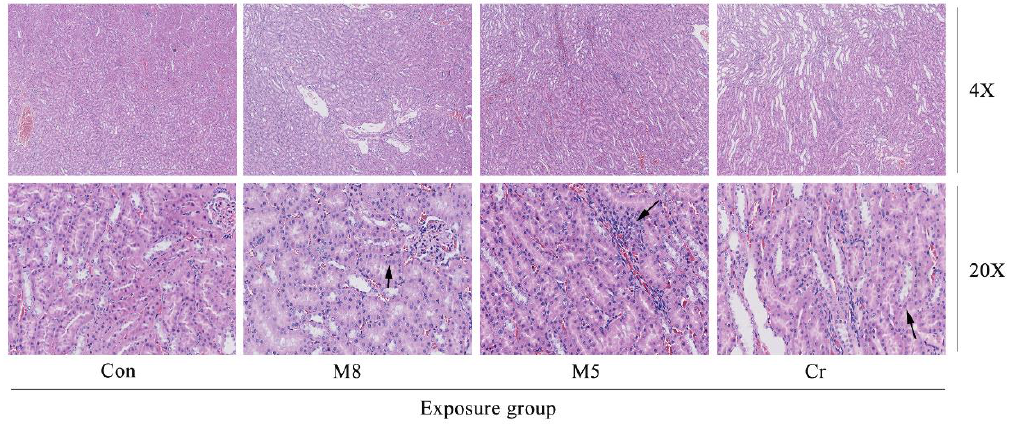
Figure 6. Photomicrographs of kidney histopathology. The images (magnification 4 × , 20 × ) represent the histopathological sections of the kidney. M8 group and Cr group (20 × ), large areas of renal tubular epithelial cells were cloudy and swollen, significant degeneration, vacuolar degeneration of the membrane (dark arrow). M5 group (20 × ) a large number of inflammatory cells infiltration (dark arrow). Abbreviations: Con, control group; M8: the mixture of eight common metals (Pb + Cd + Hg + Cu + Zn + Mn + Cr + Ni); M5: the mixture of five non-essential metals (Pb + Hg + Cd + Ni + Cr); Cr, chromium.